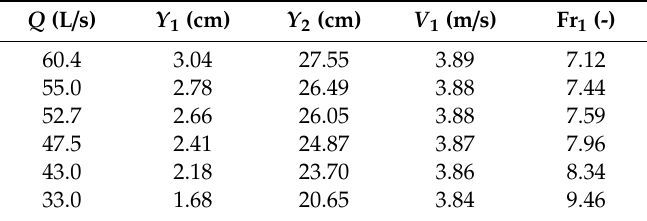
Table 1. Experimental parameters along the hydraulic